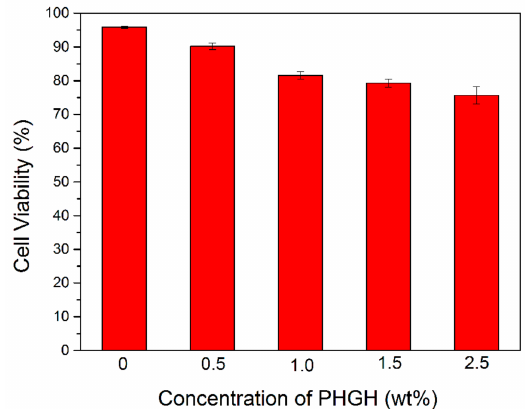
Figure 6. Histogram of cell viability of embryonic cell lines (NIH3T3) towards P-CH dressing using an MTT